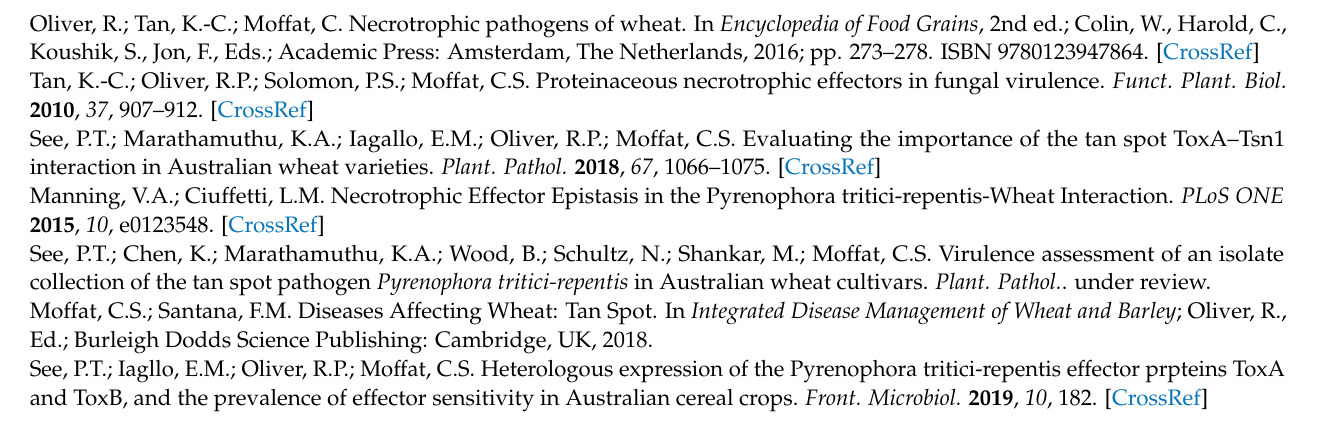
resistance on wheat chromosome 1AS, Figure S1: Distribution of mean disease scores of hexaploid wheat varieties following infection with the ∆ toxa Ptr mutant at seedling and tillering growth stages. Figure S2: Genomic location on wheat chromosome 1A of previously reported QTL markers related to tan spot disease resistance, Figure S3: Location of Ta 1AS3422 on the Chinese Springe 1A